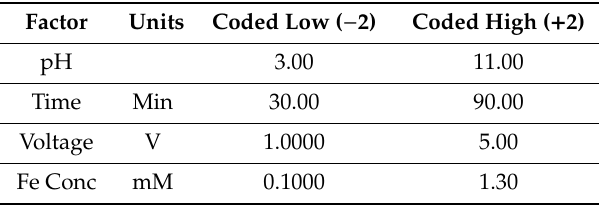
Table 1. Ranges of selected independent